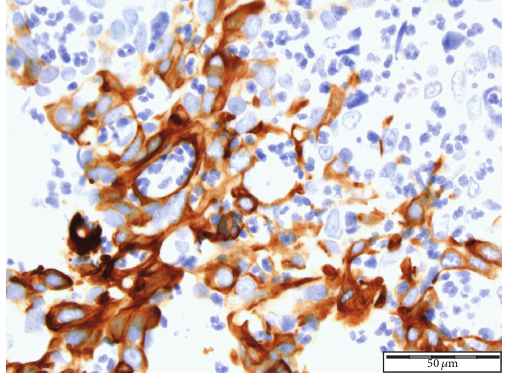
Figure 6: Immunohistochemical staining for CK20 × 40 magnifi- cation. Lymphoepithelioma-like carcinoma of the urinary bladder: the tumour cells show positive staining with CK20 reproduced